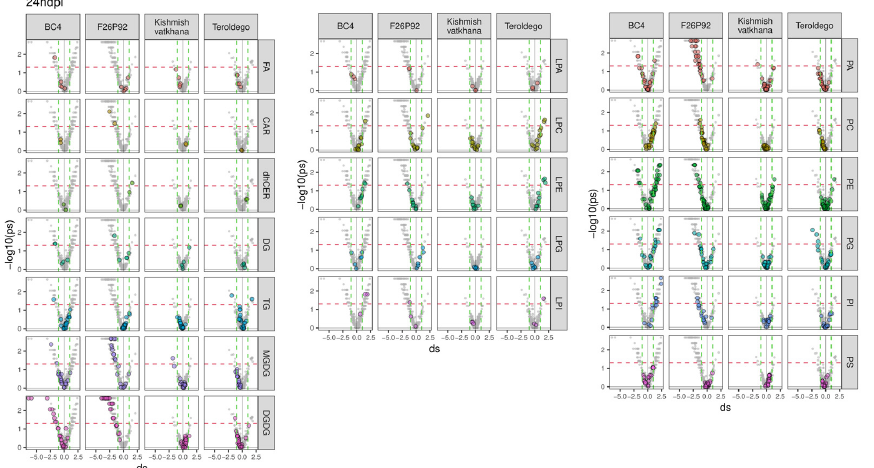
Figure 2. Lipids with values above the discontinued red line were significantly modulated with the up-accumulated lipids shown on the right and down-accumulated lipids shown on the left arm of the volcano for all four genotypes at 24 hpi over the course of the two years of data analysis (2019–2021). The left graph shows the modulation of glycerolipids, sphingolipids, and fatty acids, whereas the middle and right graphs show the modulation of glycerophospholipids. The colors reflect the various lipid classes, while “ds” represents the calculated Cohen’s d values.